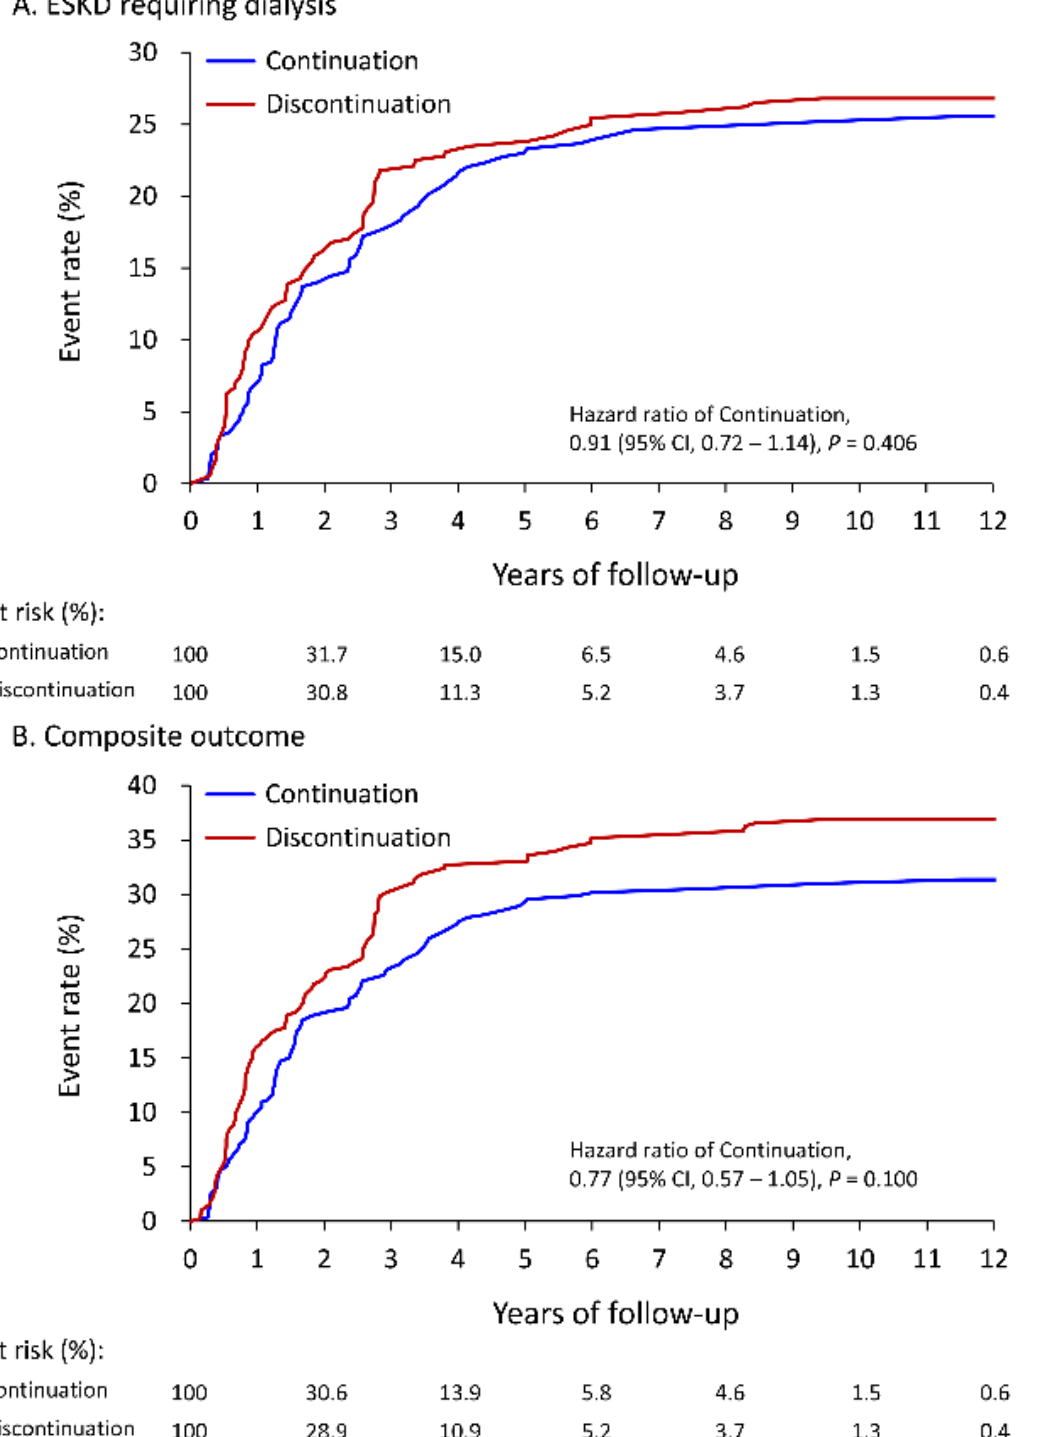
Figure 3. Cumulative event rate of ESKD requiring dialysis ( A ) and composite outcome ( B ) at the end of follow up of patients receiving ketoanalogues supplemental low protein diet in the IPTW adjusted cohort. The composite outcome included anyone of ESKD requiring dialysis, cardiovascular death, acute myocardial infarction, ischemic stroke and all-cause death. ESKD, end stage kidney disease; IPTW, inverse probability of treatment weighting.